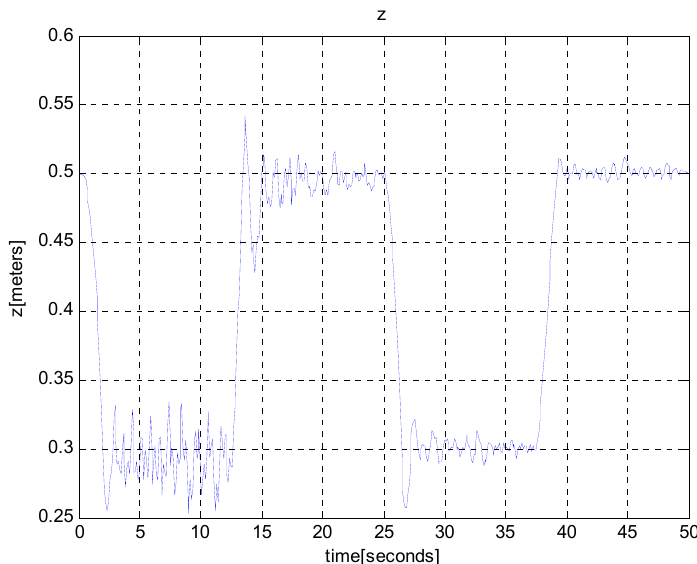
Figure 7. The depth of the vehicle with respect to time (controllers considering noisy environments and fuel consumption).